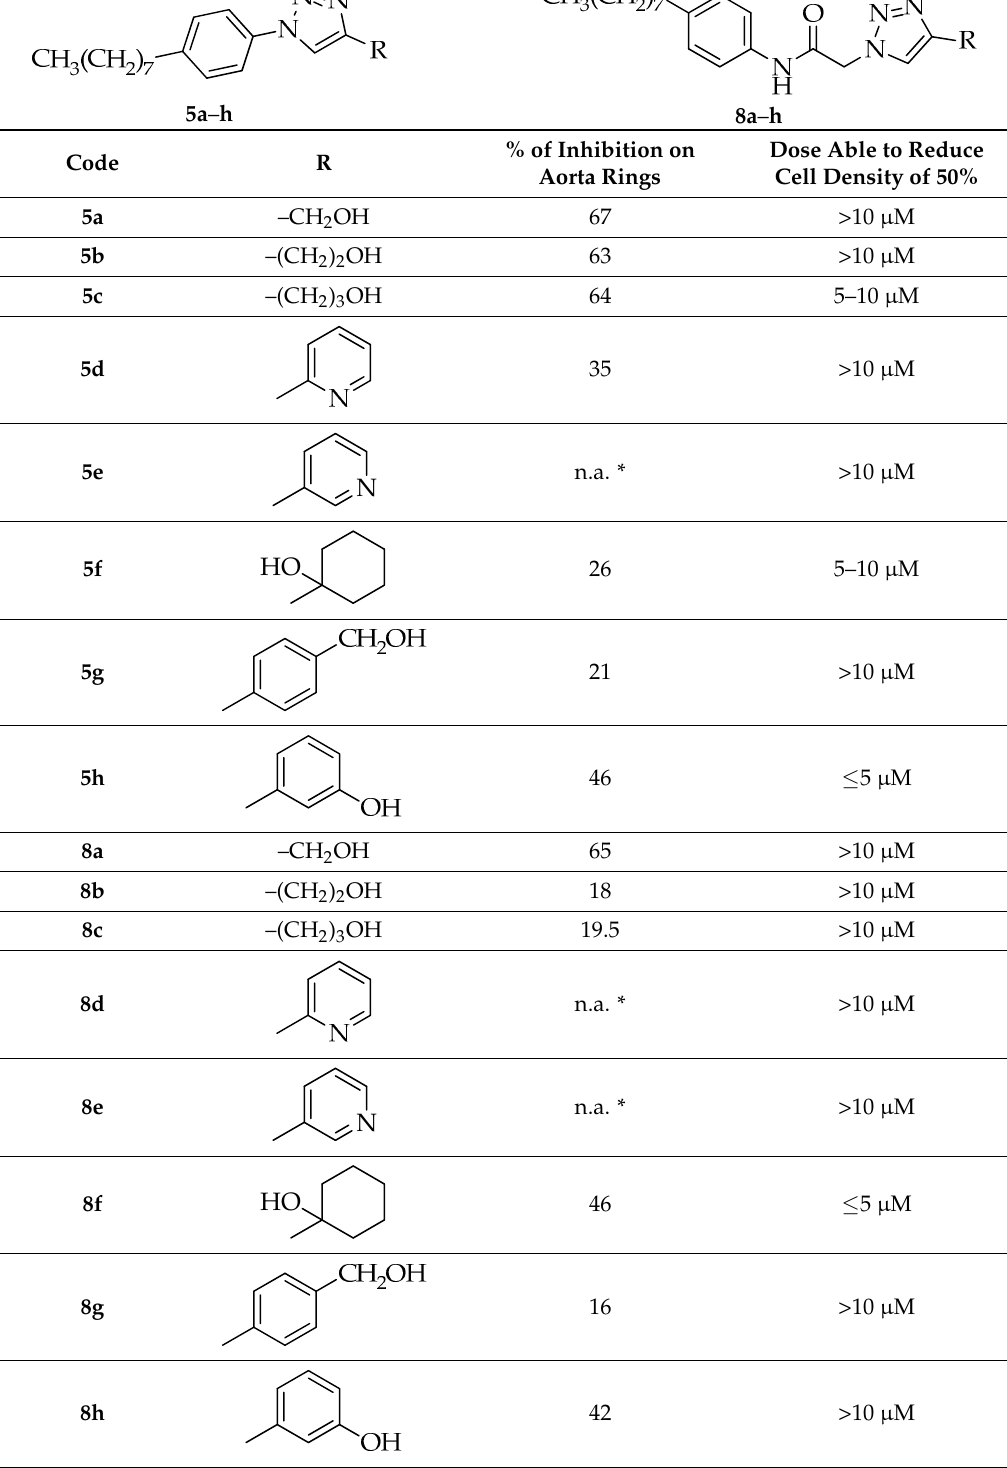
Table 1. Structures of the 1,4-disubstituted 1,2,3-triazoles 5a – h and 8a – h .